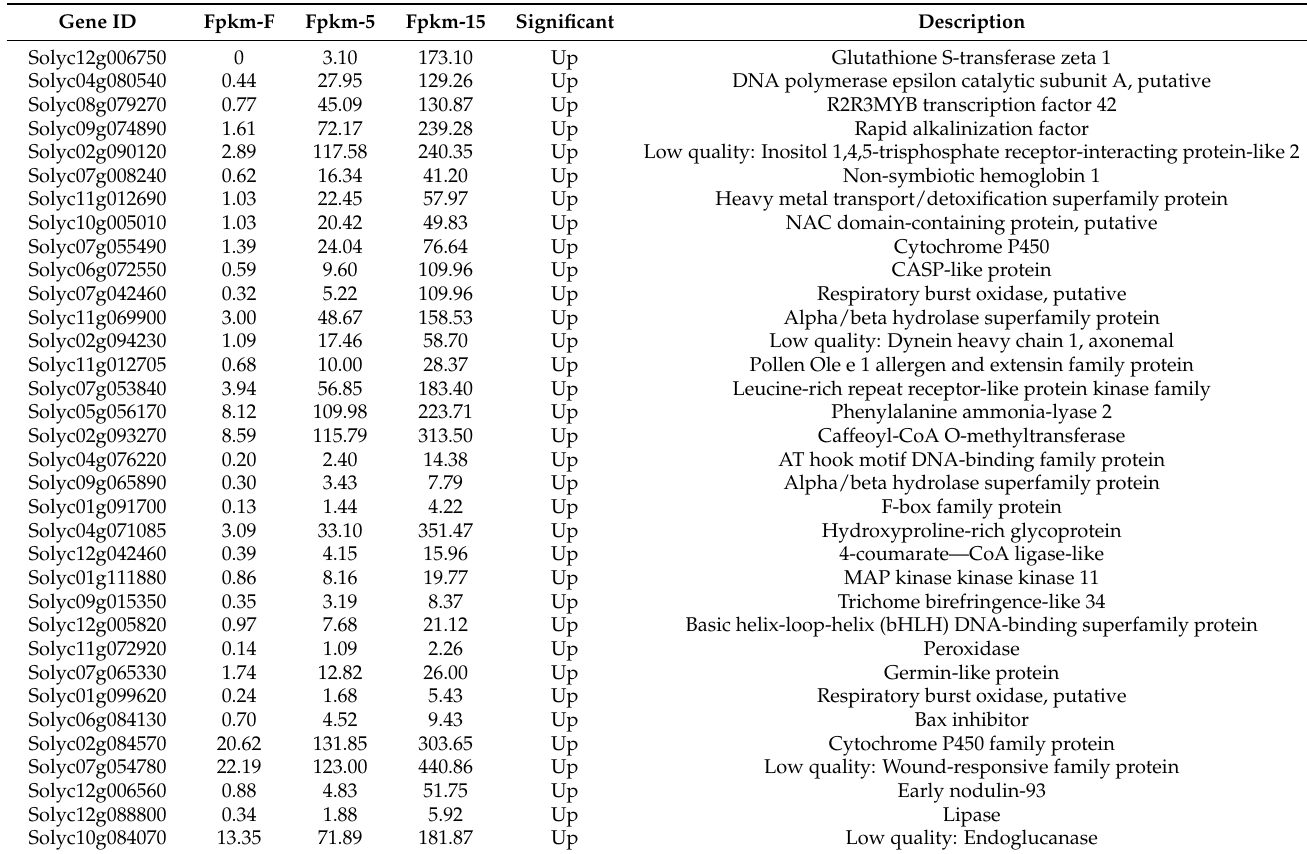
Figure 3. Venn diagram showing the numbers of up- and down-regulated genes between the three different comparisons. ( a ) Venn diagram showing the numbers of up-regulated genes between the three different comparisons. ( b ) Venn diagram showing the numbers of down-regulated genes between the three different comparisons. Table 1. The 38 significantly up-regulated genes under all three comparisons.